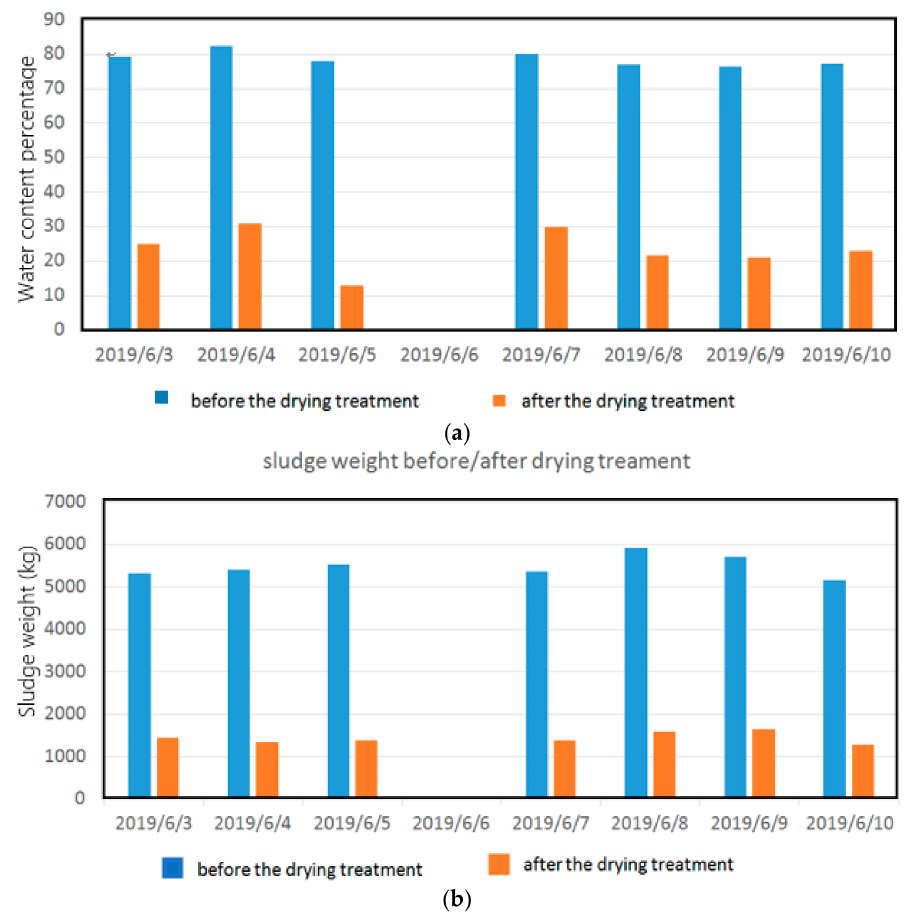
Figure 12. Variations in the average percent water content and an average weight of the sludge before and after the drying treatment by the heat pump system with an auxiliary subsystem inn experiments. ( a ) variations of average water content percentage in sludge before and after drying. ( b ) variations in the average weight of the sludge before and after